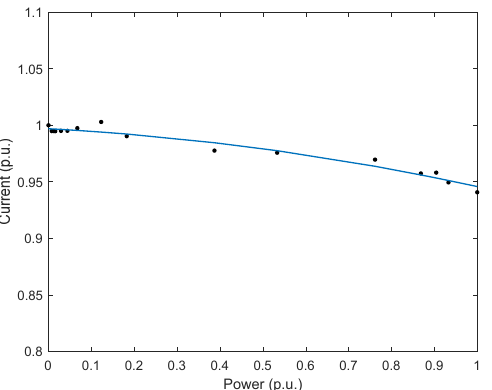
Figure 3. Dependence of the phase current I AC supplied by DSPI to the power grid versus the power P AC supplied by DSPI to the power grid.